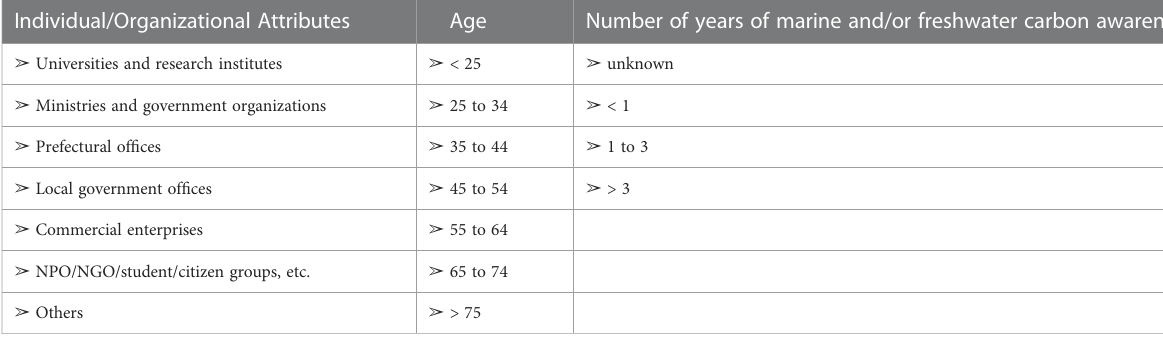
TABLE 1 Classi fi cation of respondent attributes in the questionnaire. Individual/Organizational Attributes